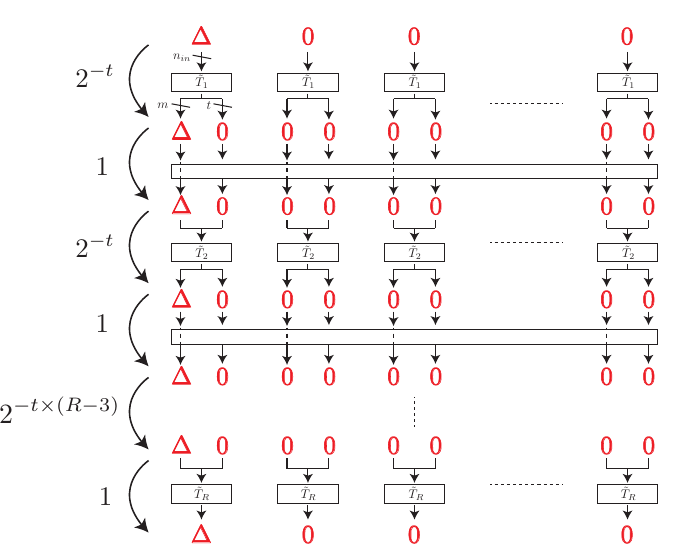
Figure 5: Truncated differential of Yoroi -core